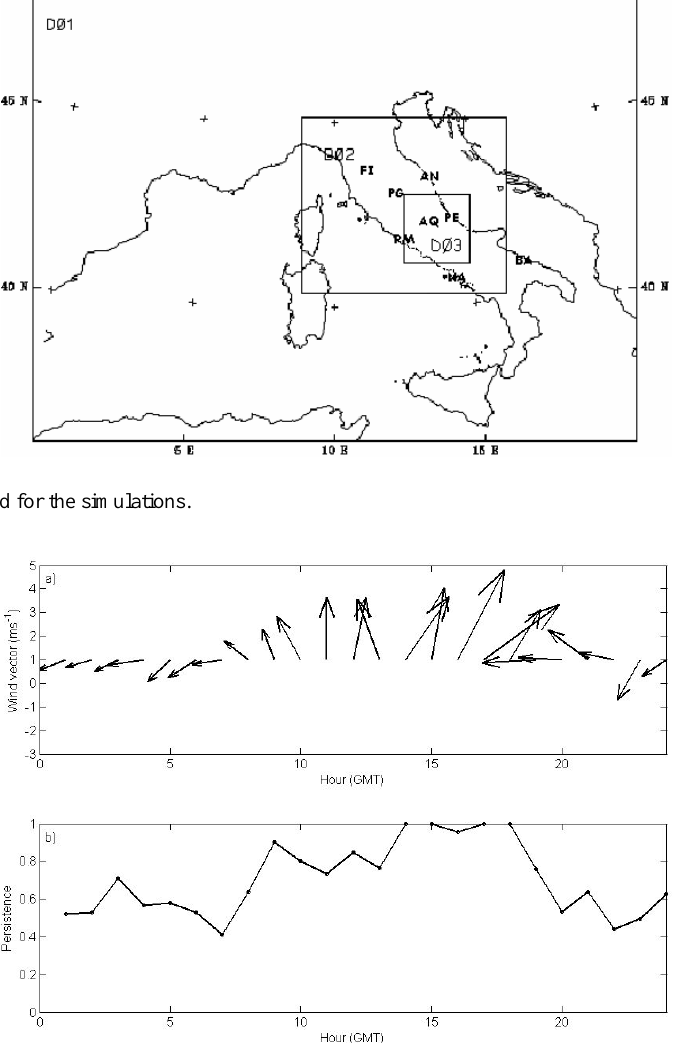
3 Mesoscale Model 5 variation of wind persistence relative to the wind vector in the upper panel. (GMT = LT - 1).